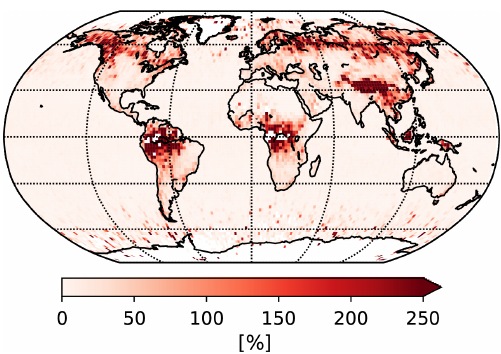
Figure 12. Relative increase of soundings that pass the v9 filtration scheme compared to v8 for the entire year 2016. Data are aggre- gated into 2 ◦ × 2 ◦ latitude–longitude square